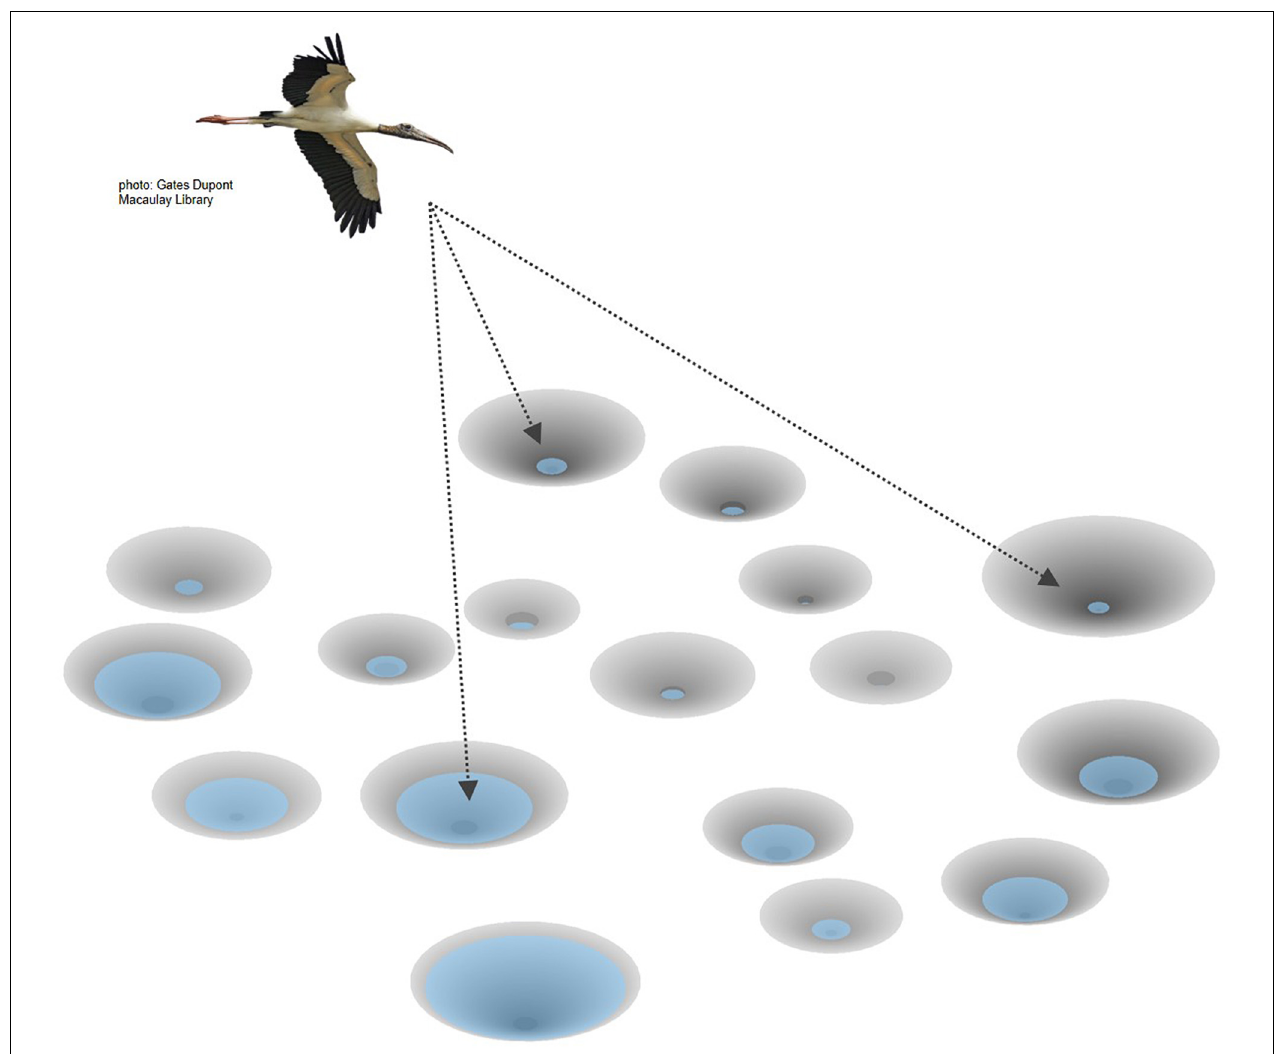
FIGURE 1 | Wading bird selecting among a conceptual array of foraging ponds with varying local hydrology. Photo: Gates Dupont, Macaulay